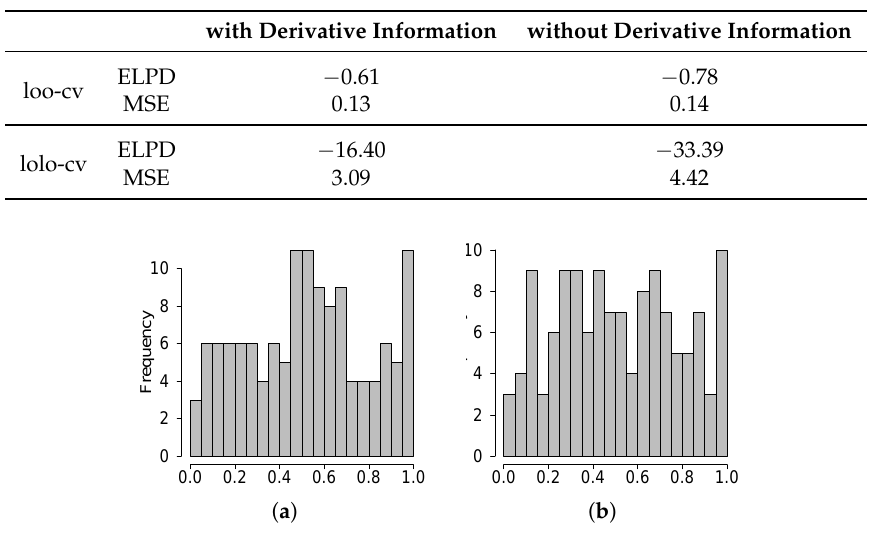
Figure 4. Histograms of the LOO probability integral transformation (LOO-PIT) by following loo-cv, for: ( a ) the model with derivatives, and ( b ) the model without